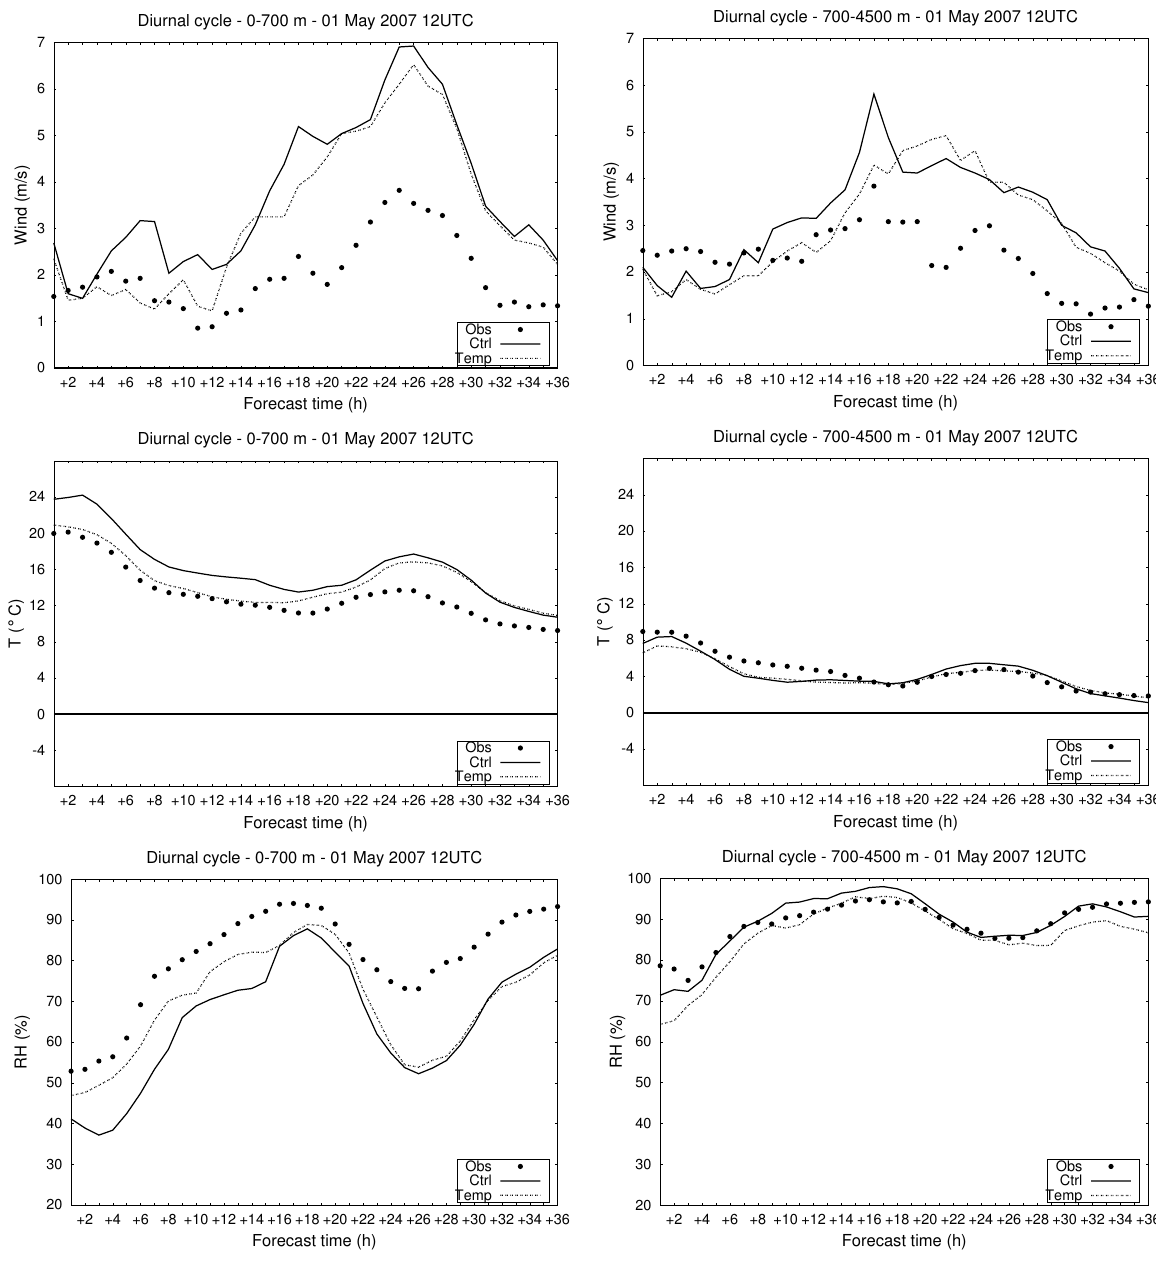
Fig. 8. Diurnal cycle for the May 2007 case, over the plains (left) and over the mountains (right); wind intensity (upper panels), temperature (middle panels) and relative humidity (bottom panels). The dots represent the Ctrl run and the dotted line represents the Temp run.